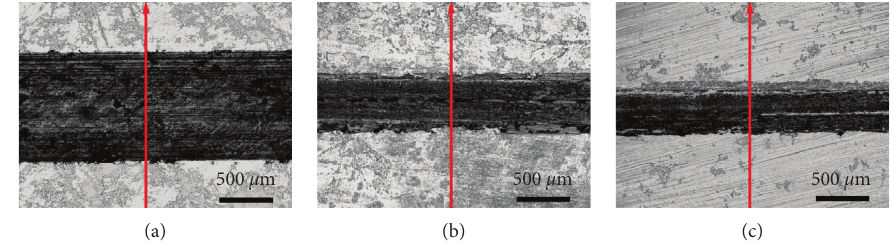
Figure 9: Micrographs of the grinding mark: (a) BM, (b) AW cladded layer, and (c) AW-LSF cladded